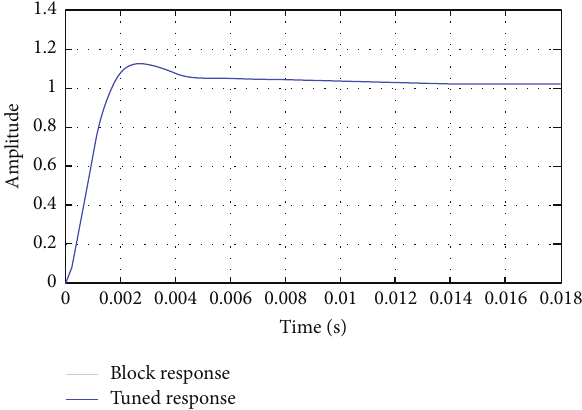
Figure 18: Reference tracking for PID